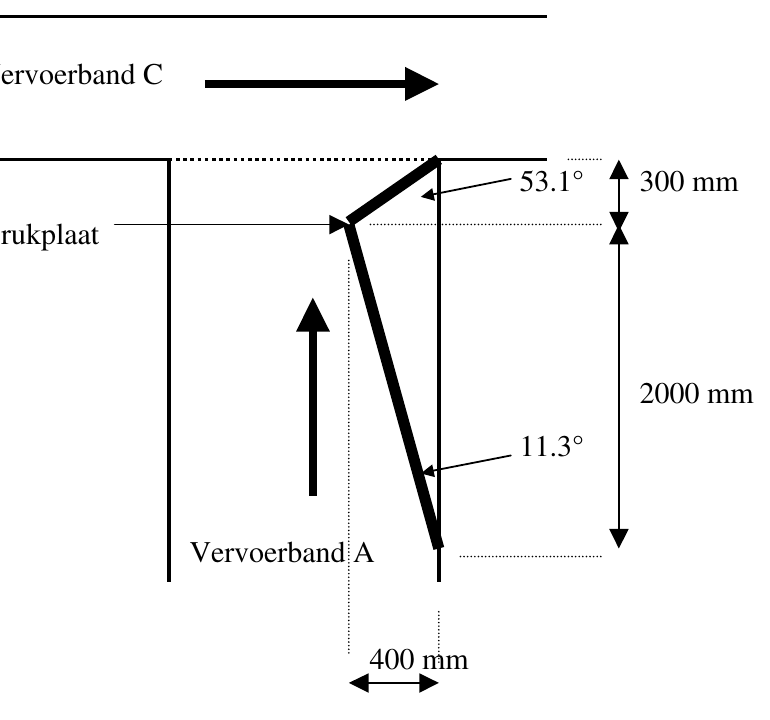
Figuur 3 ’n Voorgestelde drukplaat vir beter vloei tussen vervoerbande A en